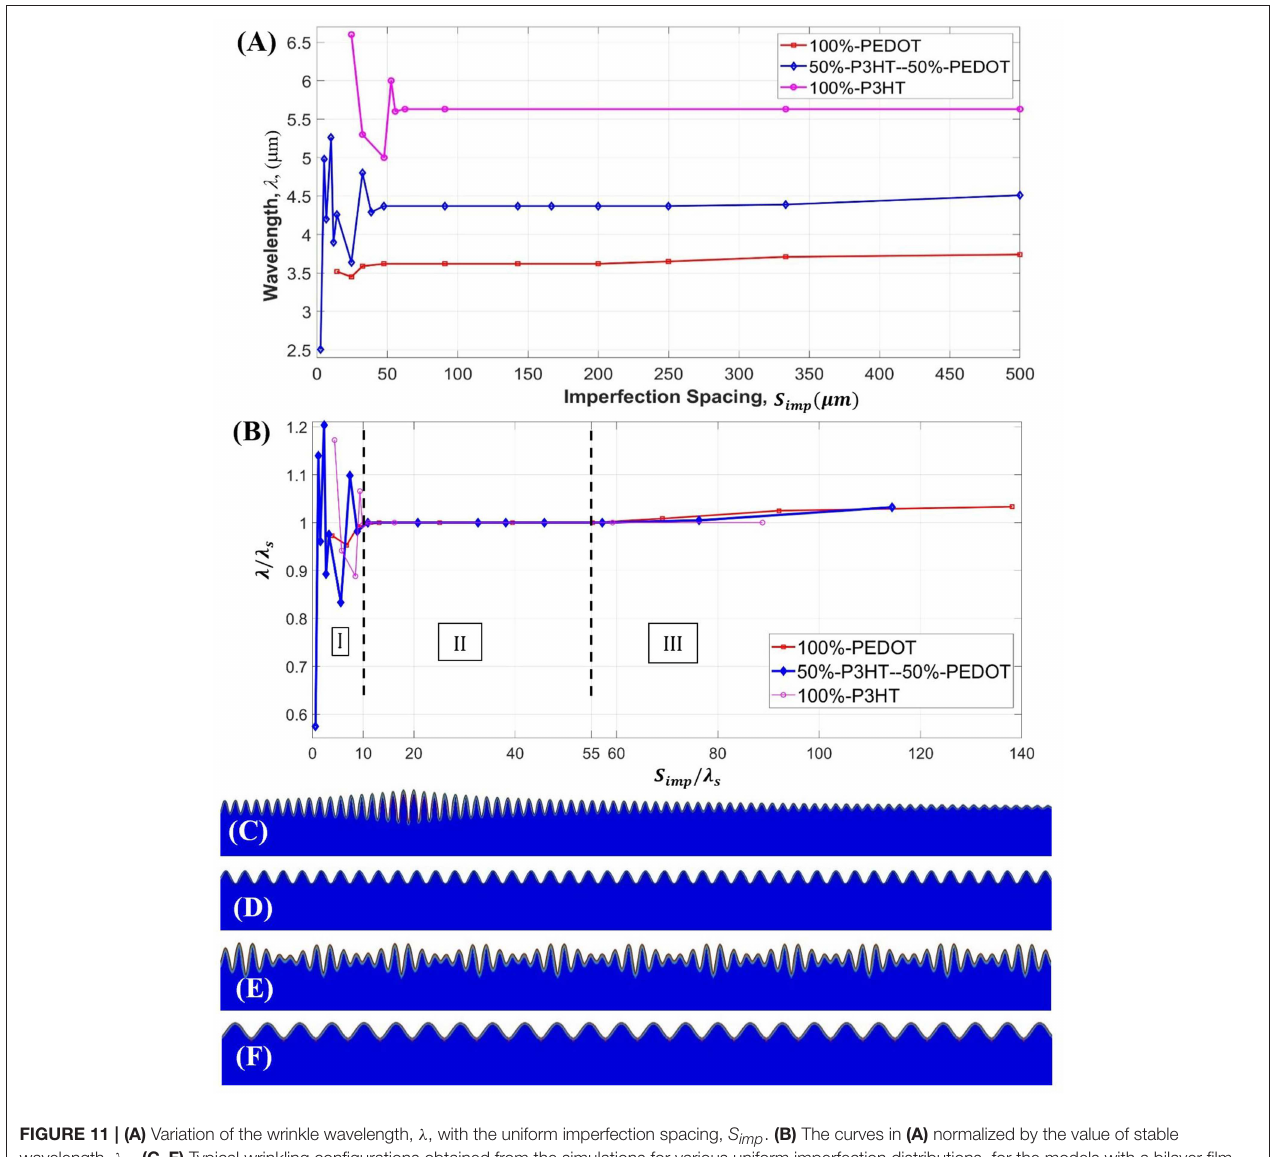
FIGURE 11 | (A) Variation of the wrinkle wavelength, λ , with the uniform imperfection spacing, S imp . (B) The curves in (A) normalized by the value of stable wavelength, λ s . (C–F) Typical wrinkling configurations obtained from the simulations for various uniform imperfection distributions, for the models with a bilayer film. > 55) corresponding to region III in (B) . (D) Fully sinusoidal wave form independent of the imperfection distribution (C) Non-uniform/localized wave pattern ( S imp λ s ≤ 55) corresponding to region II in (B) . (E,F) Complex wave patterns as the imperfection spacing becoming smaller ( S imp λ < 10) corresponding to region I (10 ≤ S imp λ s s ≤ 1). Various displacement scaling factors were used in in (B) . Note that in (F) the uniform sinusoidal wave is fully controlled by the very dense imperfections ( S imp λ s (C–F) for better visualization, and the images cover only a portion of the surface region.